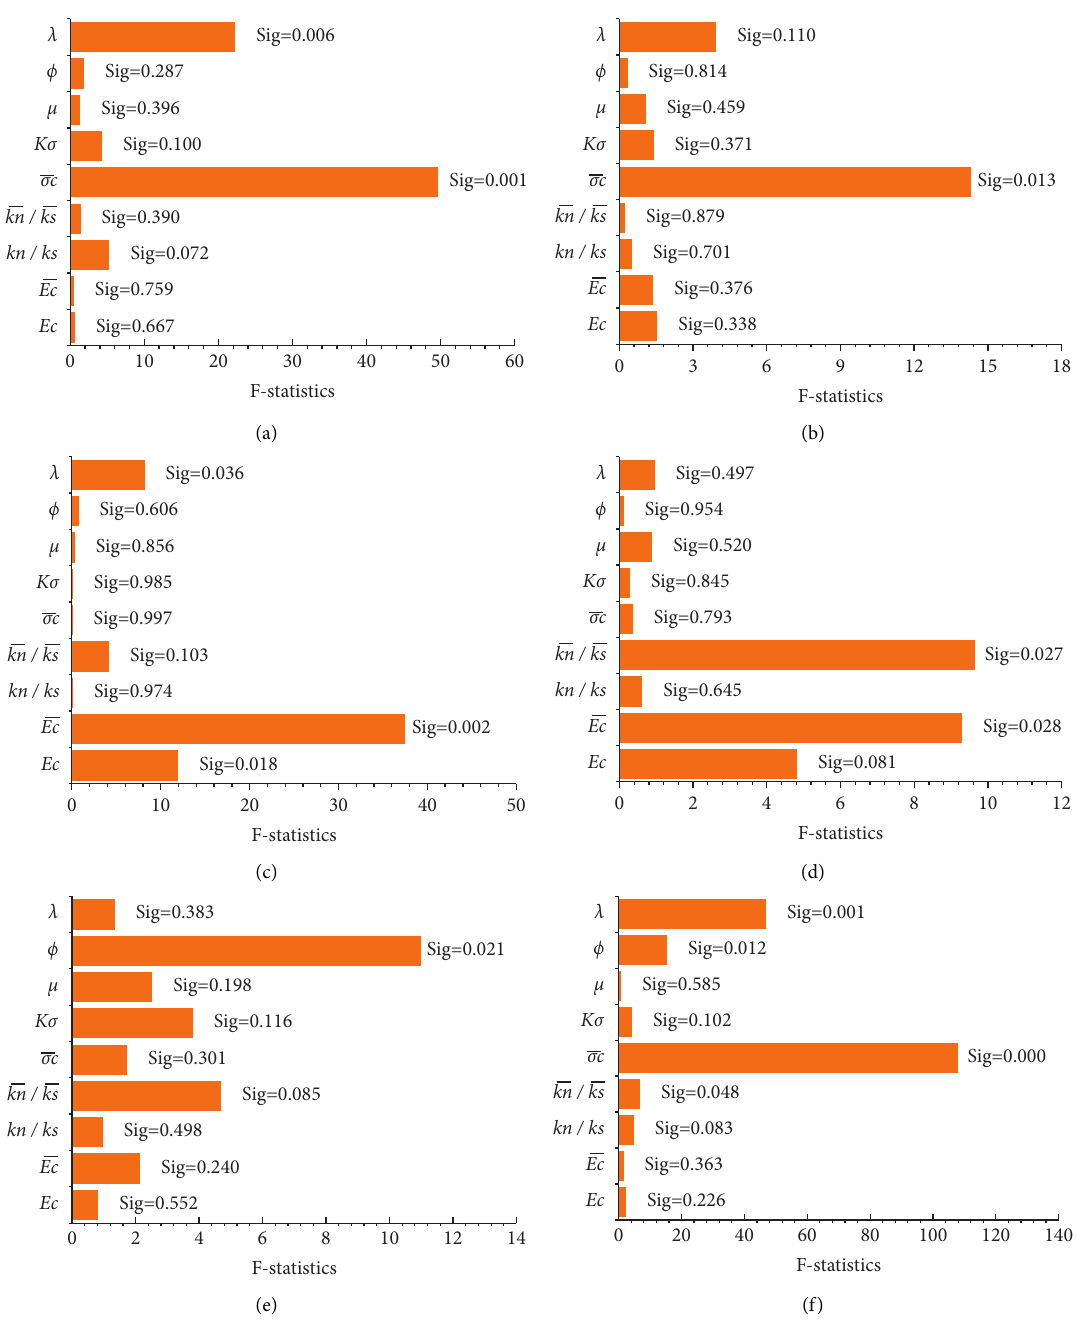
Figure 4: F statistics of multifactor analysis of variance. (a) Uniaxial compressive strength. (b) Tensile strength. (c) Elasticity modulus. (d) Poisson’s ratio. (e) Internal friction angle. (f) Cohesive